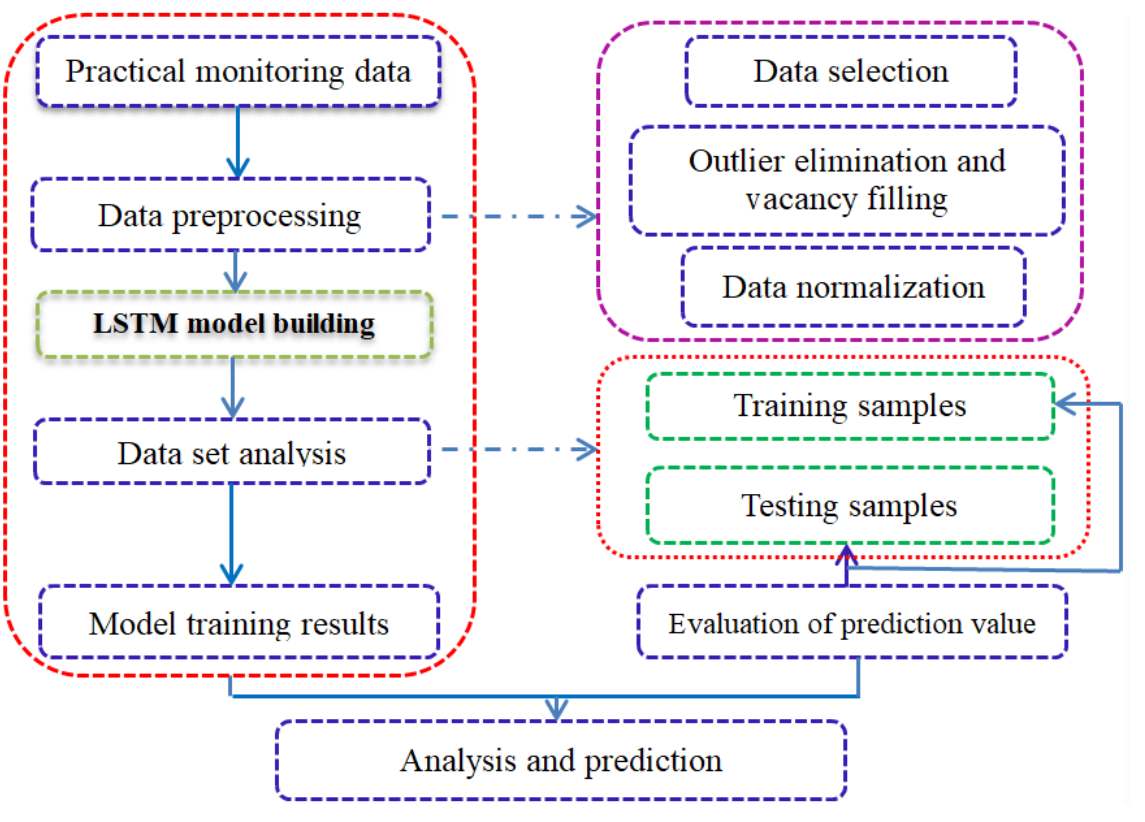
Figure 5. Technical route of LSTM analysis and prediction.